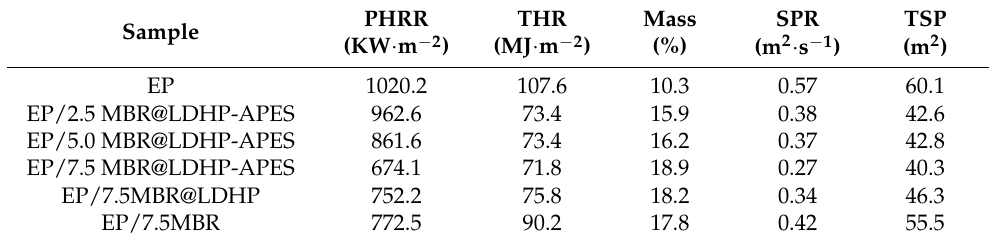
Figure 7. HRR ( a ) and THR( b ) curves of pure EP and its composites.